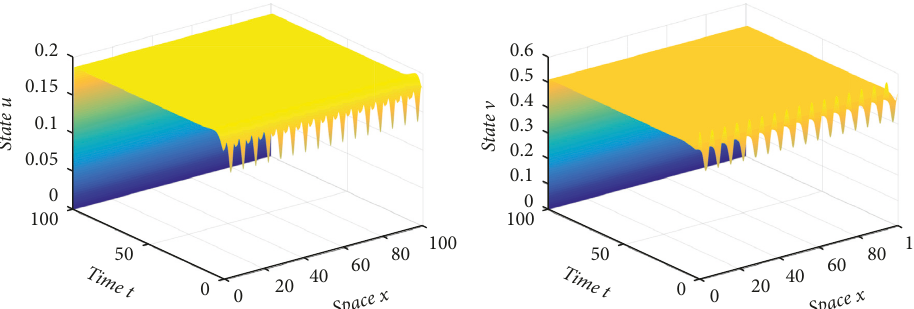
Figure 2: Spatiotemporal evolution behaviors of prey and predator of system (10) with D u ( 0 ,x ) � 0 . 187 + 0 . 1 cos x, v ( 0 , x ) � 0 . 515 + 0 . 3 cos x .